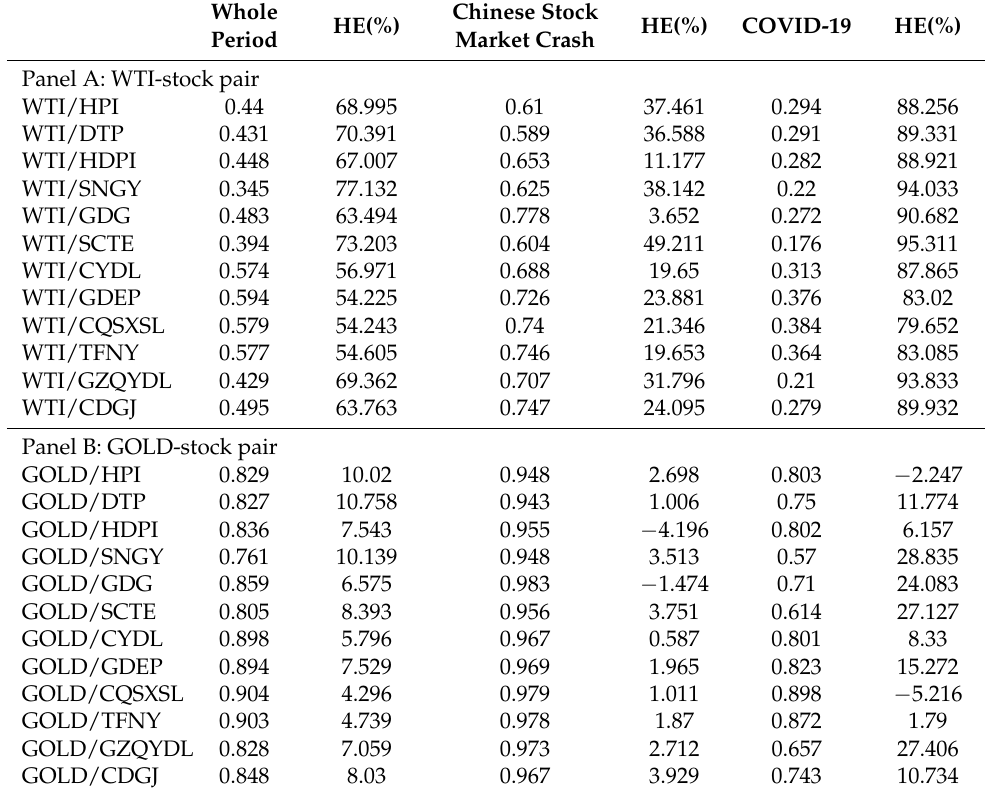
Table 6. Portfolio weights and the corresponding hedging